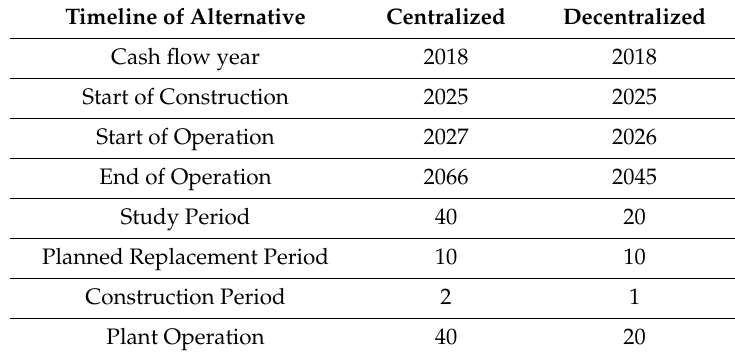
Table A2. Cash flow input data and duration period.